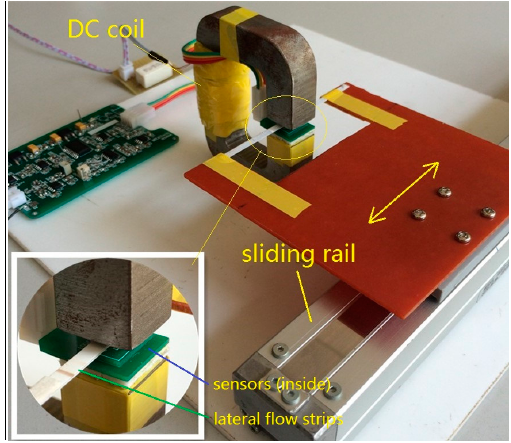
Figure 6. General view of the prototype. The sensors are TMR2705 and the magnetic core is with a cross-section 16 × 16 mm and an air gap 8 mm.